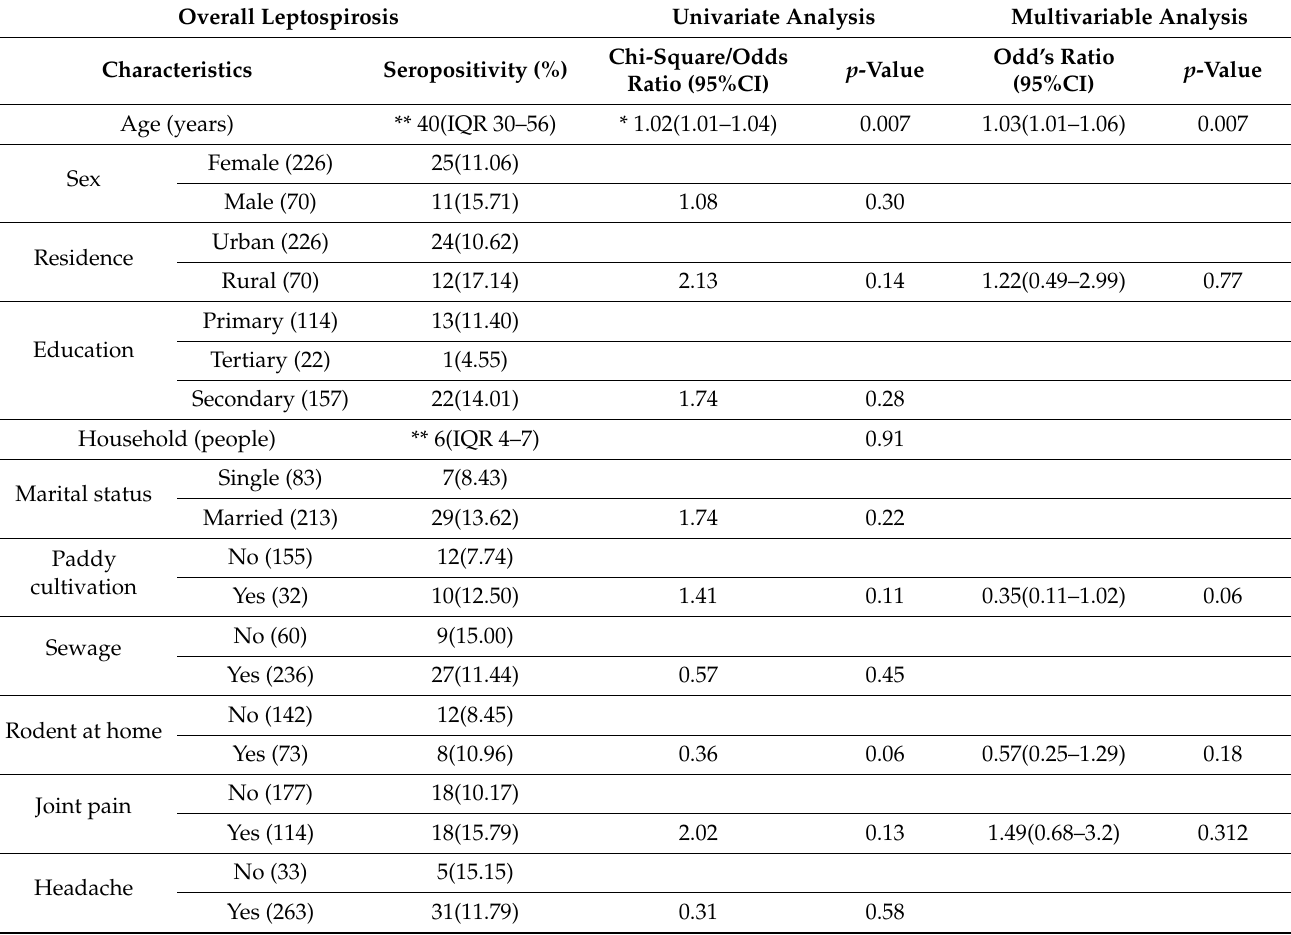
Table 4. Univariate and multivariate logistic regression analysis of the factors associated with Leptospira seropositivity among 296 febrile adults in Mwanza,